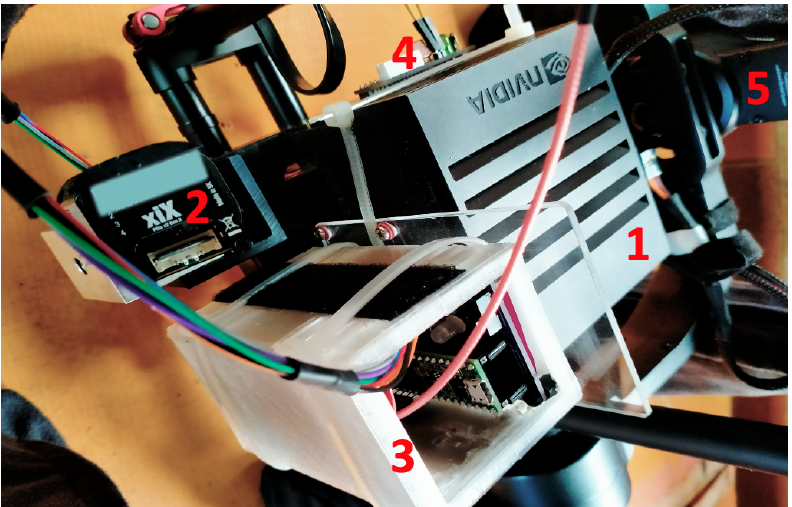
Figure 7. The openhsi software is run on an NVIDIA Jetson Xavier (1) and collects data from the camera (2). To facilitate post-processing, an ancillary sensor suite (3) is connected to the Jetson’s GPIO header via a breakout PCB (4). The whole assembly is fixed and balanced inside a Ronin gimbal